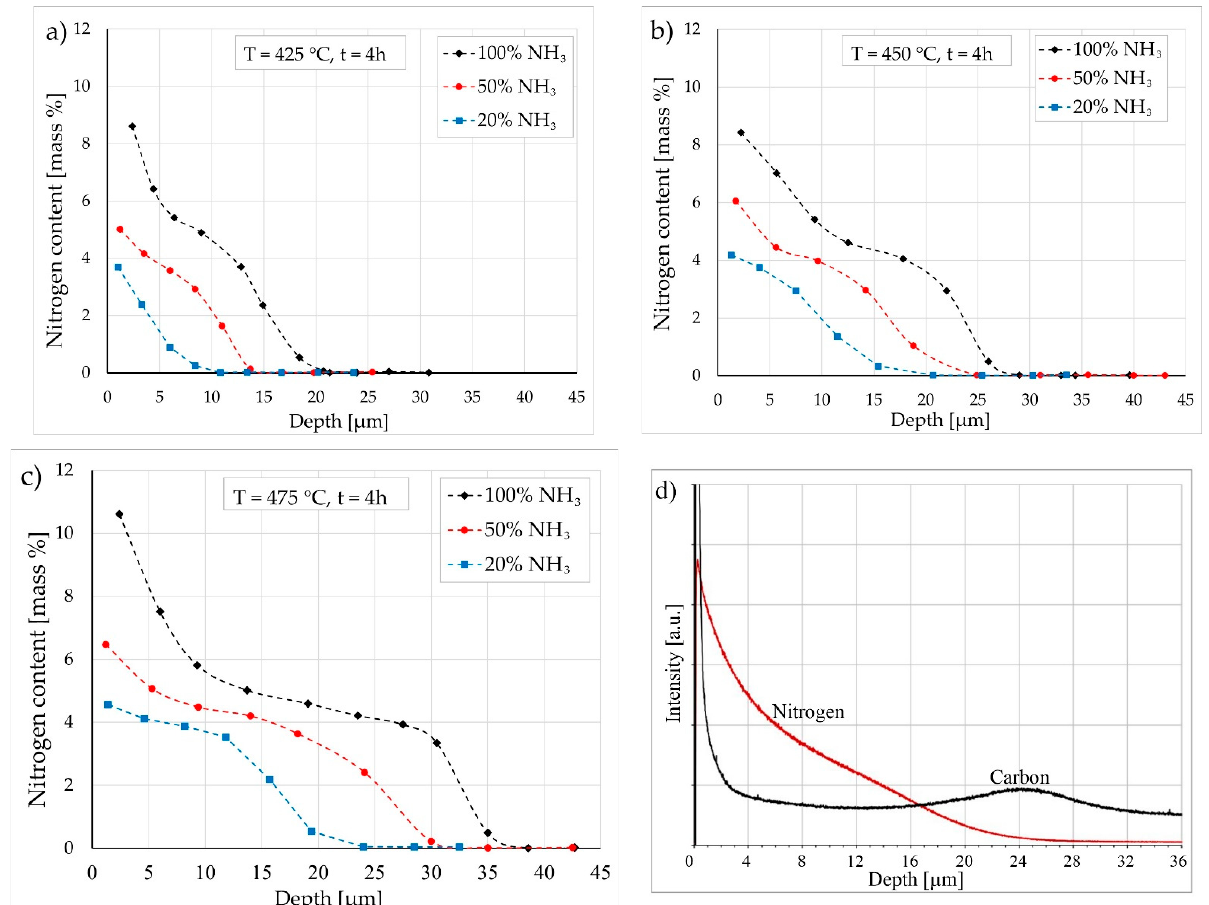
Figure 5. ( a – c ) Quantitative distribution of nitrogen on cross sections of nitrided layers on Nanoflex steel under condition C with various treatment parameters (treatment time: 4 h), WDS X-ray microanalysis. ( d ) Qualitative distribution of nitrogen and carbon on cross sections of nitrided layer (450 °C, 50% NH 3 , 4 h) on Nanoflex steel under condition C, GDOES.